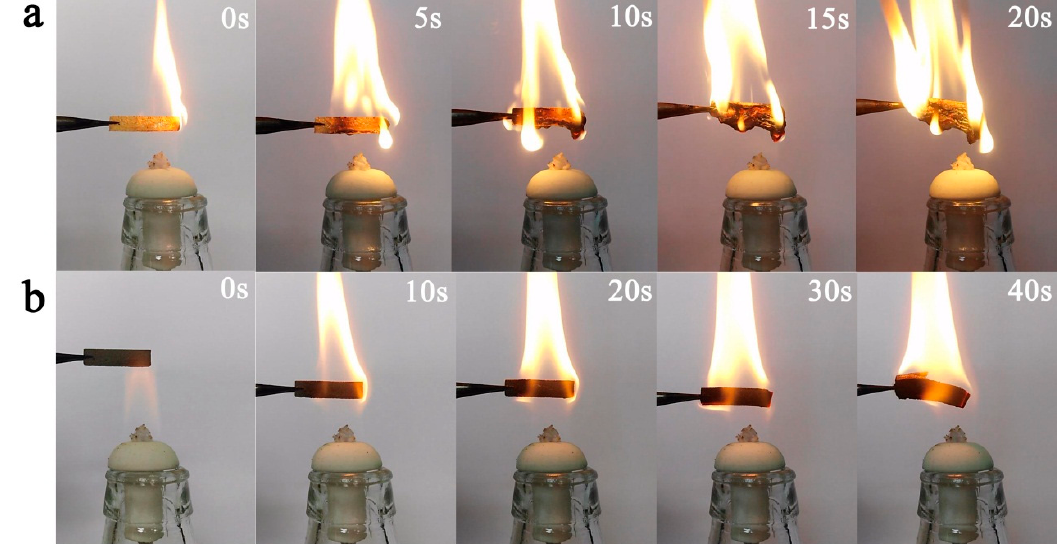
Figure 5. Thermal stability of PRC. To better understand the fire-resistant performance of PRC, the combustion progress of polyurethane and PRC in air was investigated. As shown in Figure 6, an alcohol lamp was used to